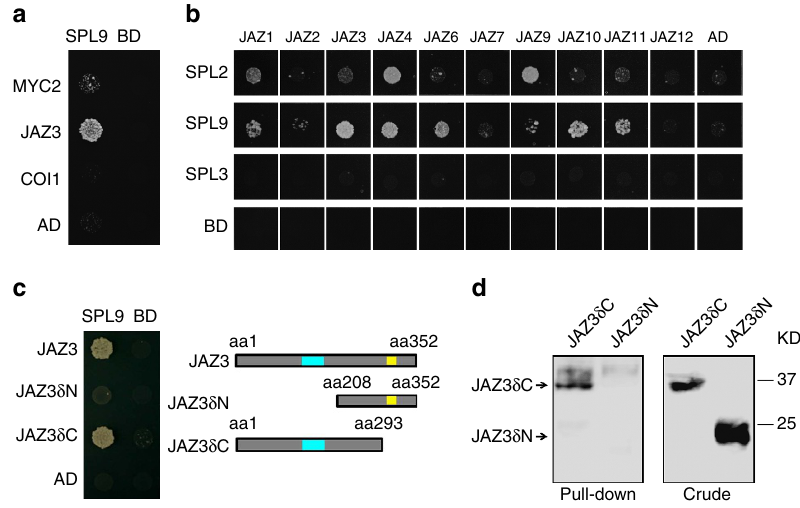
Figure 4 | SPL proteins can interact with JAZ proteins. Yeast two-hybrid assay. SPLs were fused to GAL4 DNA-binding domain (BD), MYC2, COI1, JAZ3, JAZ3 d N and JAZ3 d C was fused to GAL4 activation domain (AD), respectively. Interactions were examined with 10mM (for SPL2 and SPL3) or 15mM (for SPL9) 3-amino-1,2,4-triazole. Schematic diagrams of truncated versions of JAZ3 are shown in c , blue box indicates ZIM domain and yellow box indicates Jas domain. SPL9 and SPL2, but not SPL3, interacted with JAZs ( a , b ), and the N-terminal of JAZ3 was responsible for binding to SPL9 ( c ). ( d ) Pull-down assay of JAZ3-SPL9 binding. Recombinant HIS-SPL9 protein was incubated with total proteins of the tobacco leaf expressing either JAZ3 d N-HA or JAZ3 d C-HA driven by the 35S promoter. Anti-HA antibody was used to detect the truncated fusion proteins of JAZ3 before (Crude) or after (Pull-down) immunoprecipitation. KD,